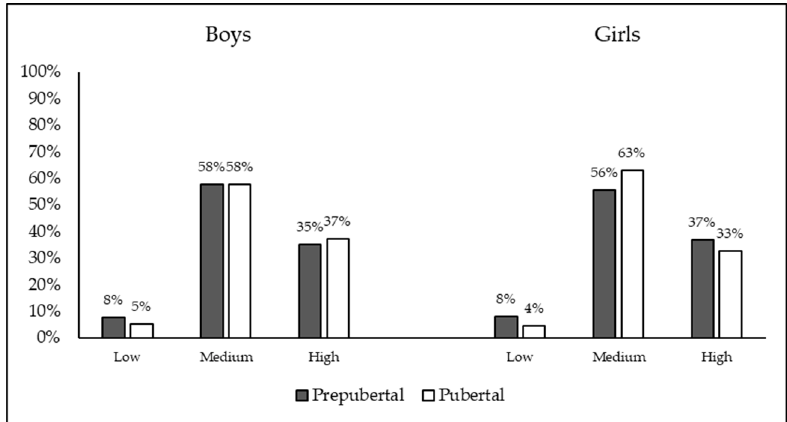
Figure 2. Percentage of the sample with different KIDMED classifications as a function of sex and pubertal status.